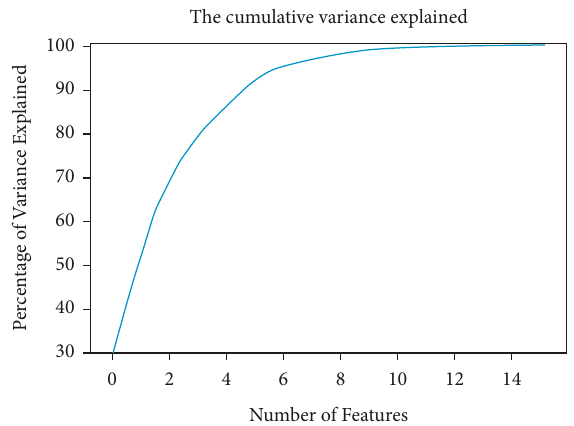
Figure 3: The cumulative contribution rate of principal